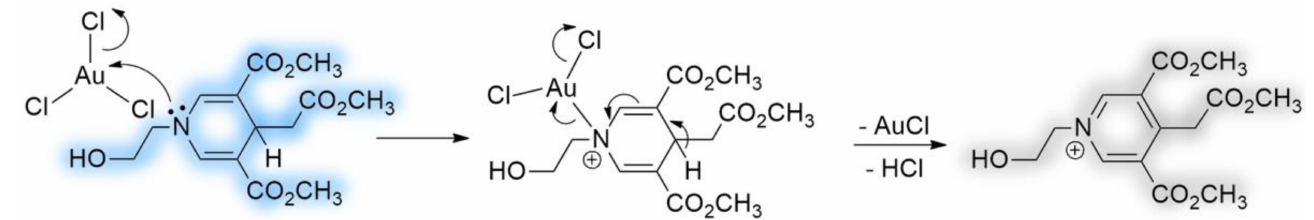
Scheme 2. Proposed mechanism of Au 3+